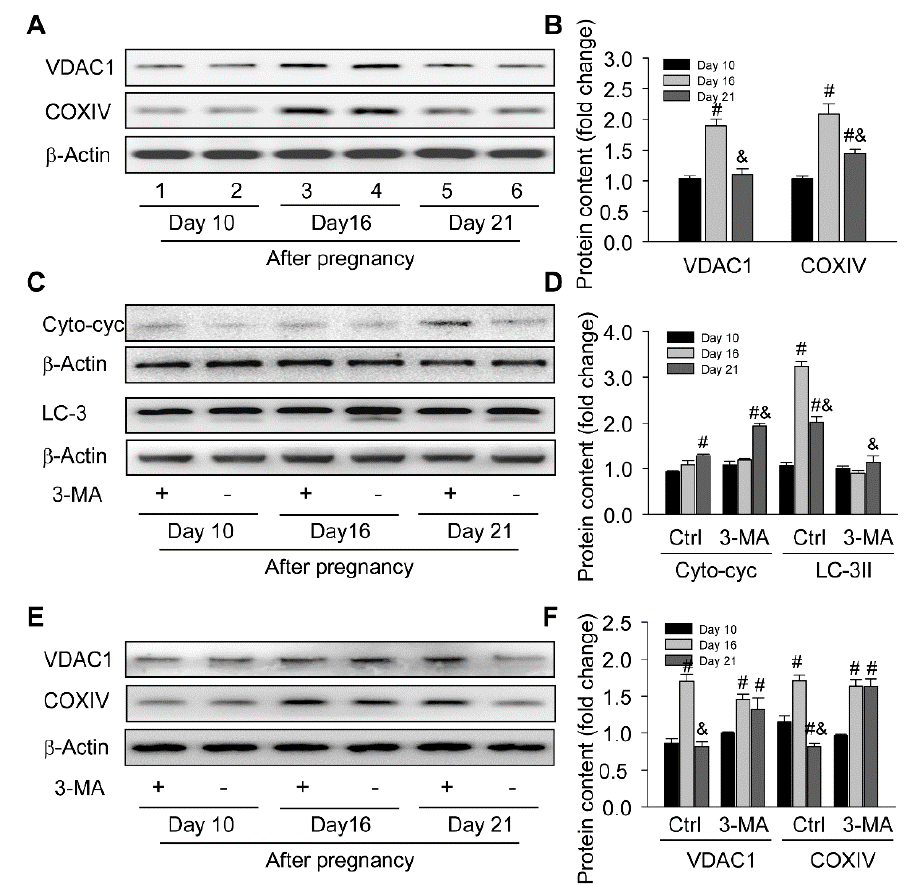
Figure 8. Requirement of autophagy for mitochondria homeostasis in ovaries during the luteal development of pregnant rats: ( A ) representative western blot analyses depicting the protein levels of VDAC1 and COXIV in ovaries during the luteal development of pregnant rats; ( B ) summarized intensities of VDAC1 and COXIV blots normalized to the control; ( C ) representative western blot analyses depicting the protein levels of Cyto-cyc and LC-3 in ovaries with or without 3-MA treatment during the luteal development of pregnant rats; ( D ) summarized intensities of Cyto-cyc and LC-3II blots normalized to the control; ( E ) representative western blot analyses depicting the protein levels of VDAC1 and COXIV in ovaries with or without 3-MA treatment during the luteal development of pregnant rats; ( F ) summarized intensities of VDAC1 and COXIV blots normalized to the control. Each value represents the mean ± SE, n = 6. ANOVA was used to analyze the data. #: p < 0.05 vs. p on day 10 &: p < 0.05 vs. p on day 16. 3-MA: an autophagy inhibitor.